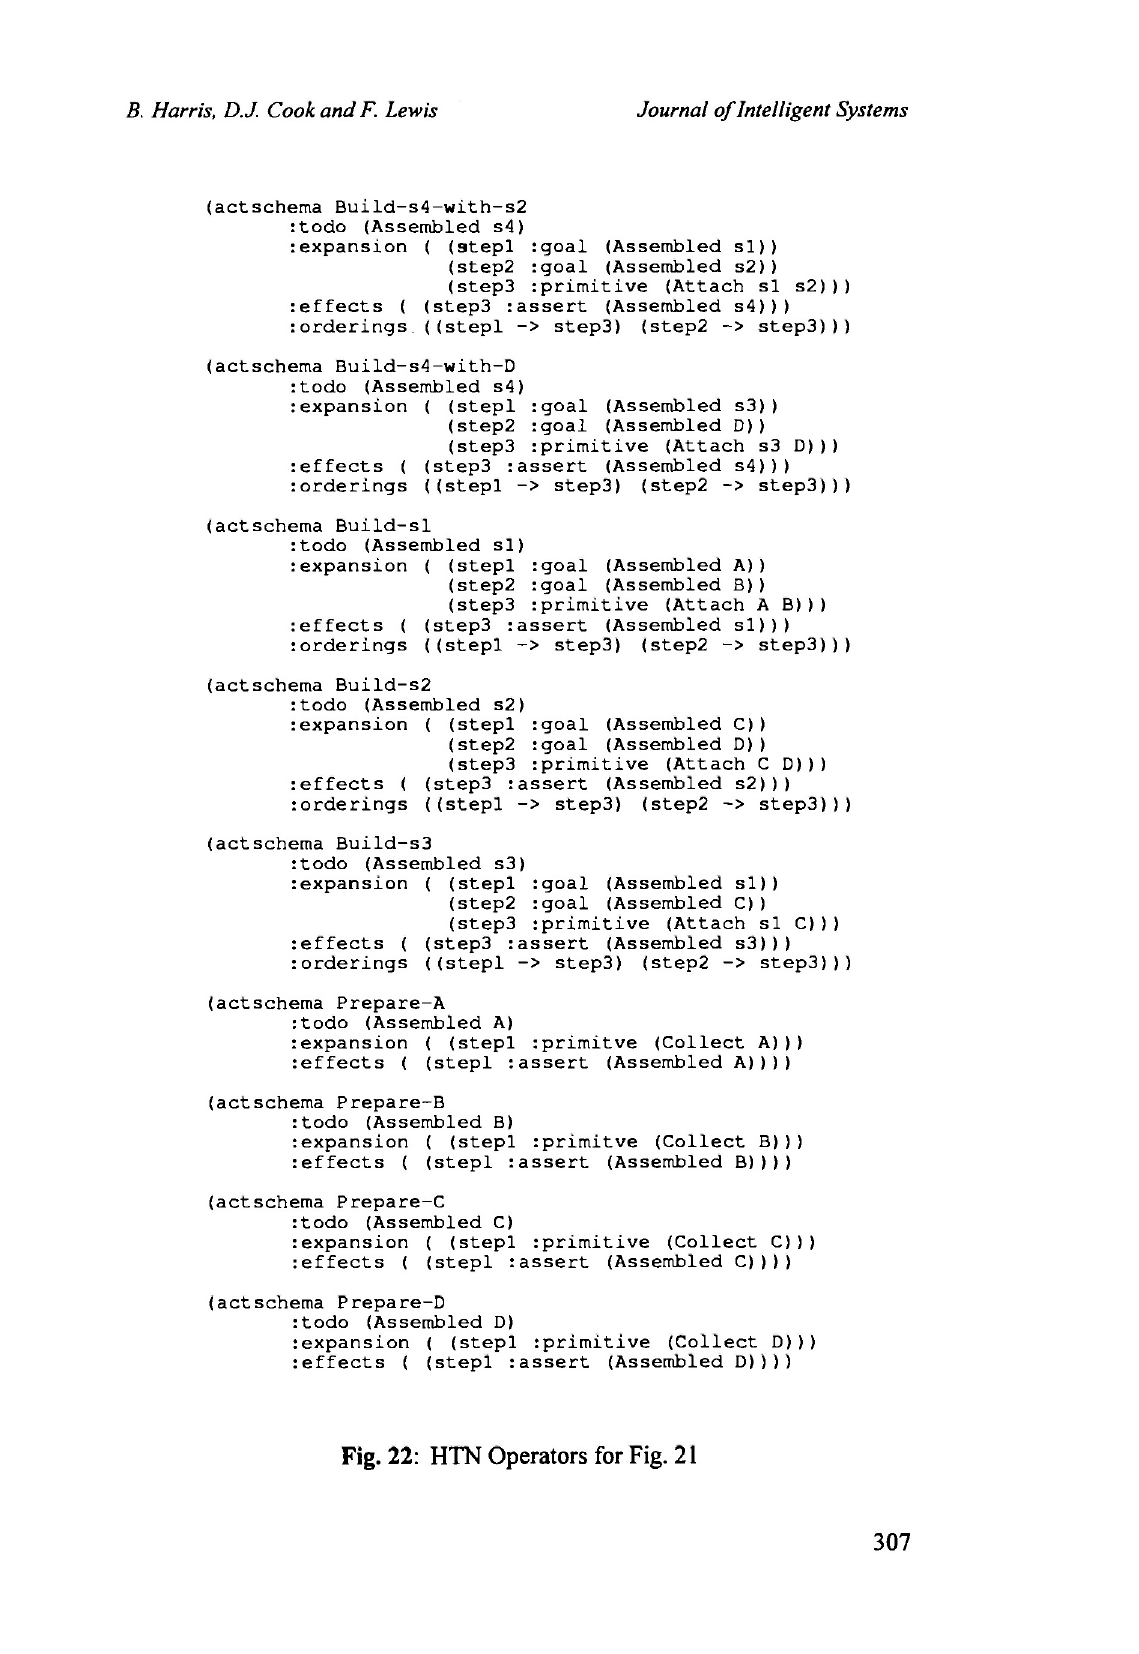
Fig. 22: HTN Operators for Fig. 21